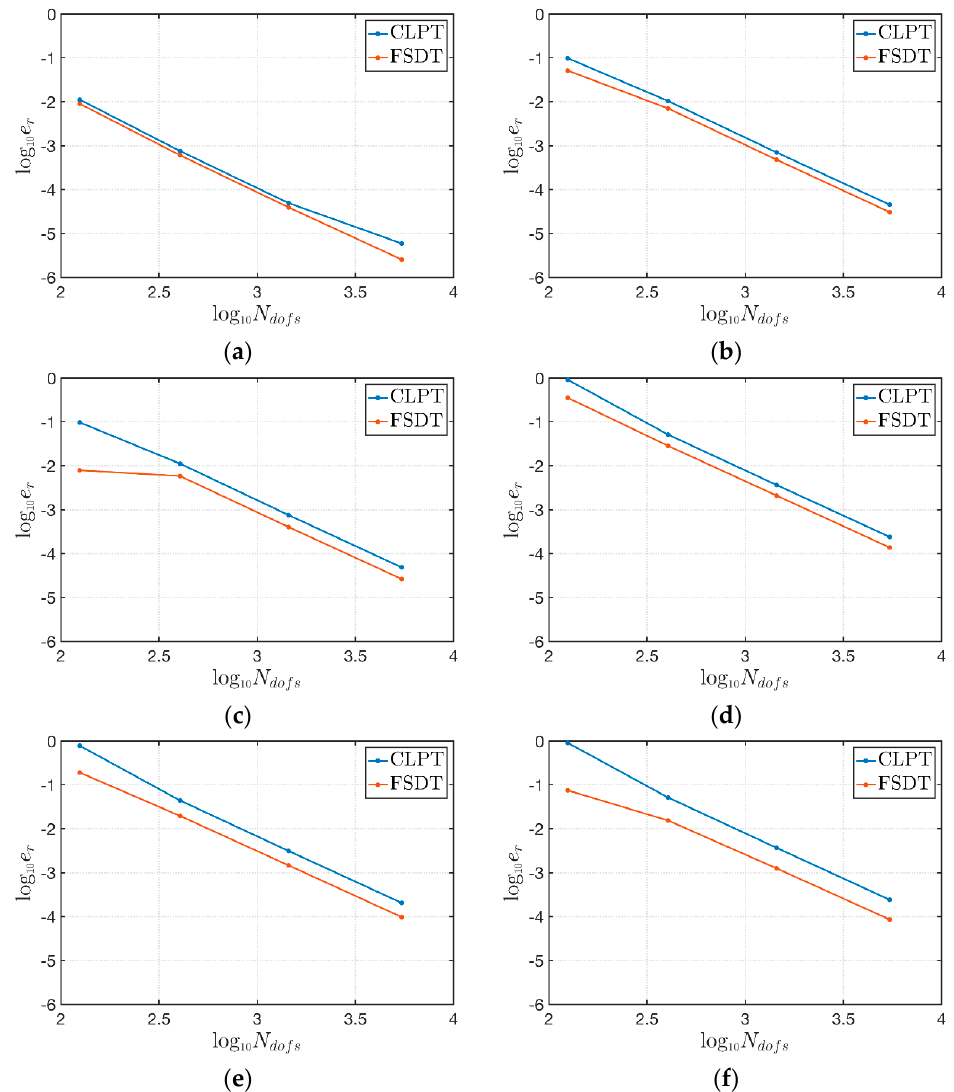
Figure 4. Convergence graphs for thin (CLPT) and thick (FSDT) laminated plates in terms of natural frequencies: ( a ) first frequency; ( b ) second frequency; ( c ) third frequency; ( d ) fourth frequency; ( e ) fifth frequency; ( f ) sixth frequency.